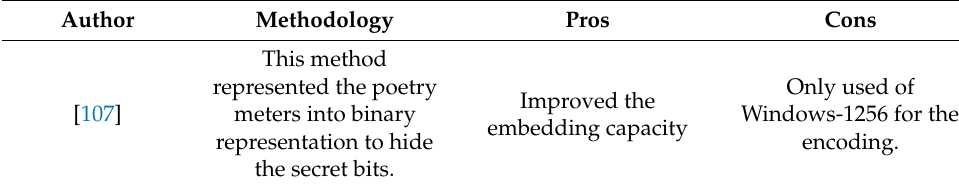
Table 18. A summary of the reviewed article on the poetry approach.